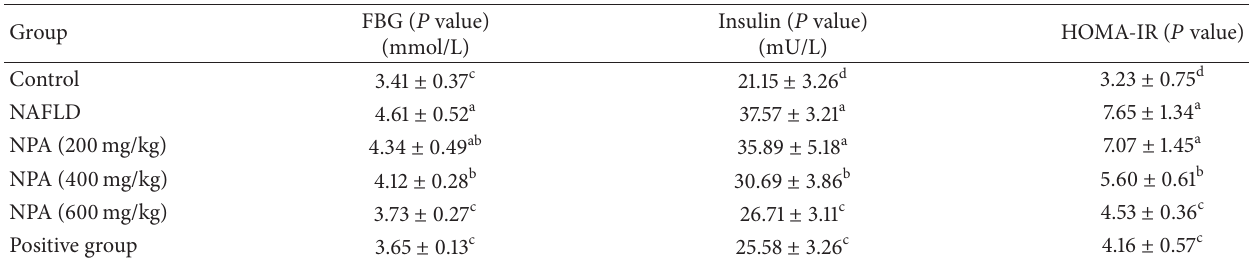
Table 2: Effect of NPA on serum levels of glucose, insulin, and insulin sensitivity index in all groups of rats.